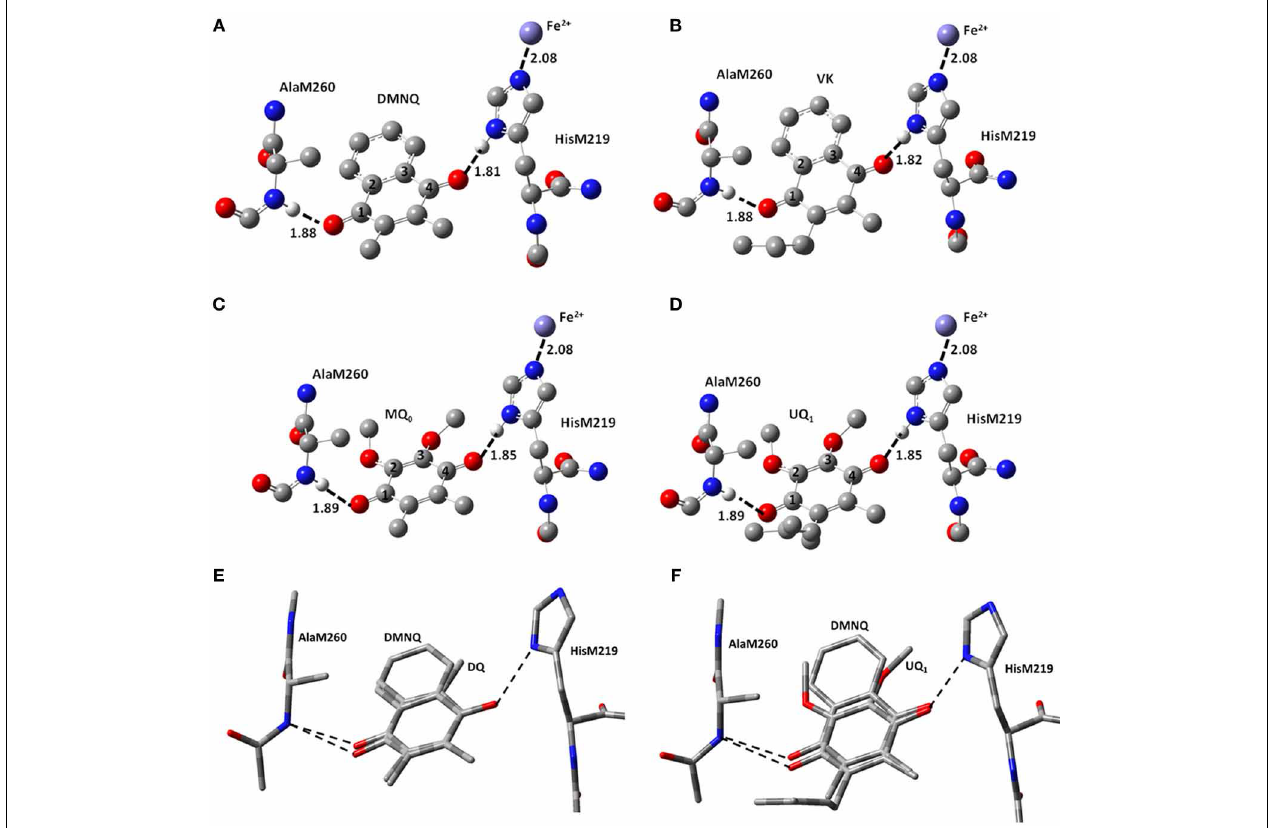
FIGURE 2 | Ball and stick representation of the calculated structure of (A) DMNQ, (B) VK, (C) MQ 0 and (D) UQ 1 in the Q A binding site in PBRCs from Rb. sphaeroides . Structure shown is after geometry optimization using ONIOM methods. Possible H-bonds are shown (dotted). Hydrogen atoms, except the ones involved in H-bonding, have been